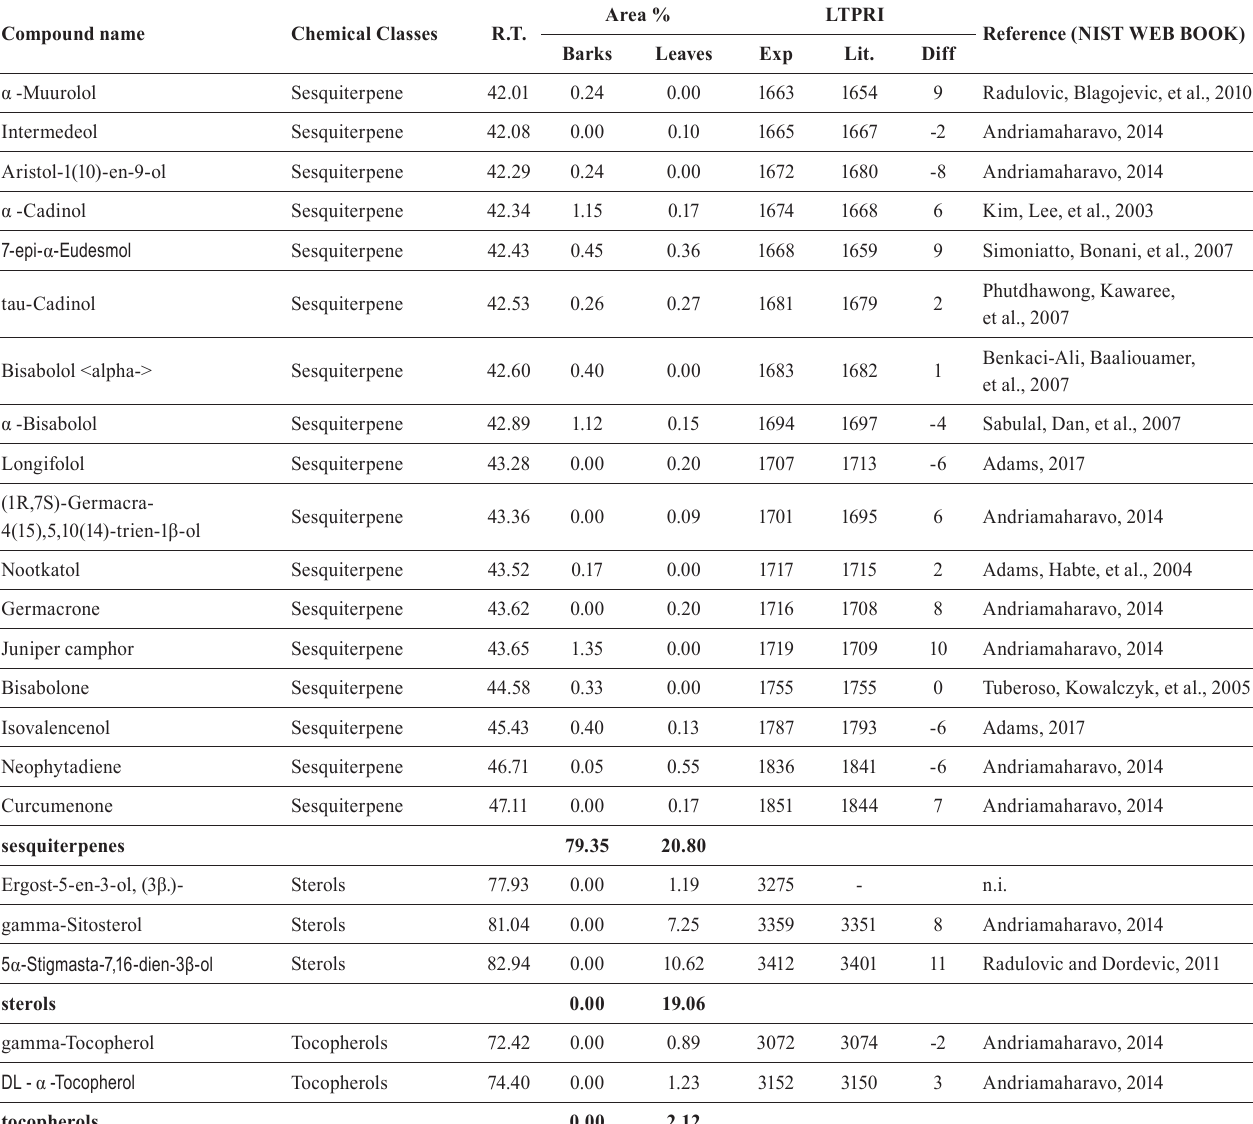
TABLE SI - Tentatively identified compounds in Essential Oils from barks and leaves of Commiphora Leptophloeos by